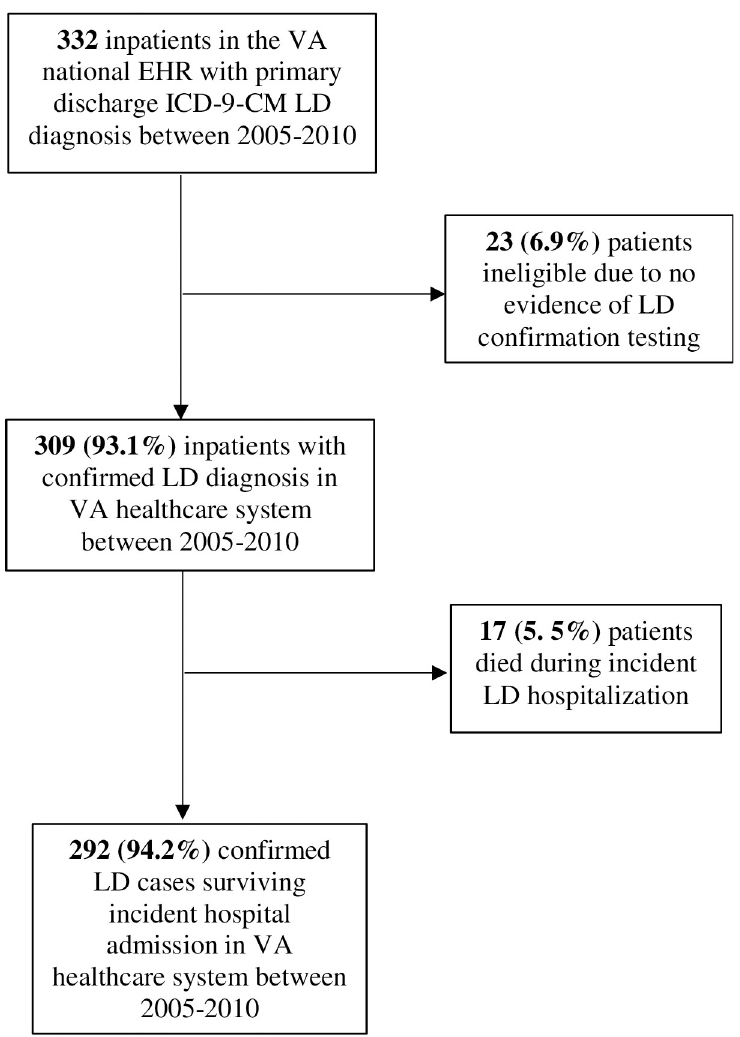
Fig 1. Study population selection from 332 VA inpatients discharged with primary ICD-9-CM diagnosis Legionnaires’ Disease (LD) between 2005–2010. Abbreviations: VA U.S. Department of Veterans Affairs; LD Legionnaires’ Disease; ICD-9-CM International Classification of Diseases, 9th revision, Clinical Modification; EHR electronic health record.